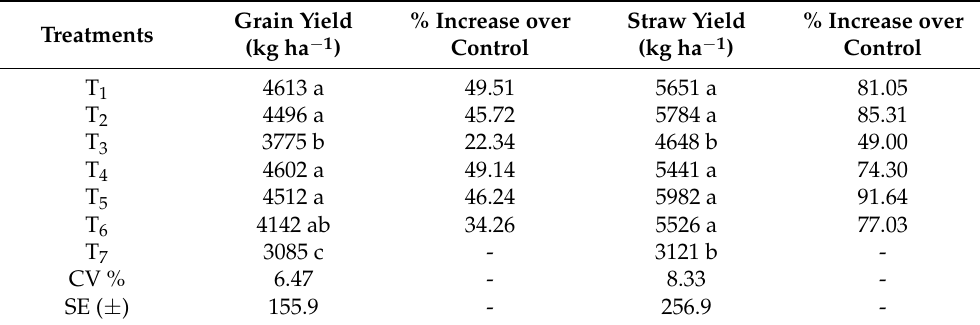
Table 2. Grain and straw yields of BRRI dhan46 as influenced by methods of deep placement of urea fertilizer.